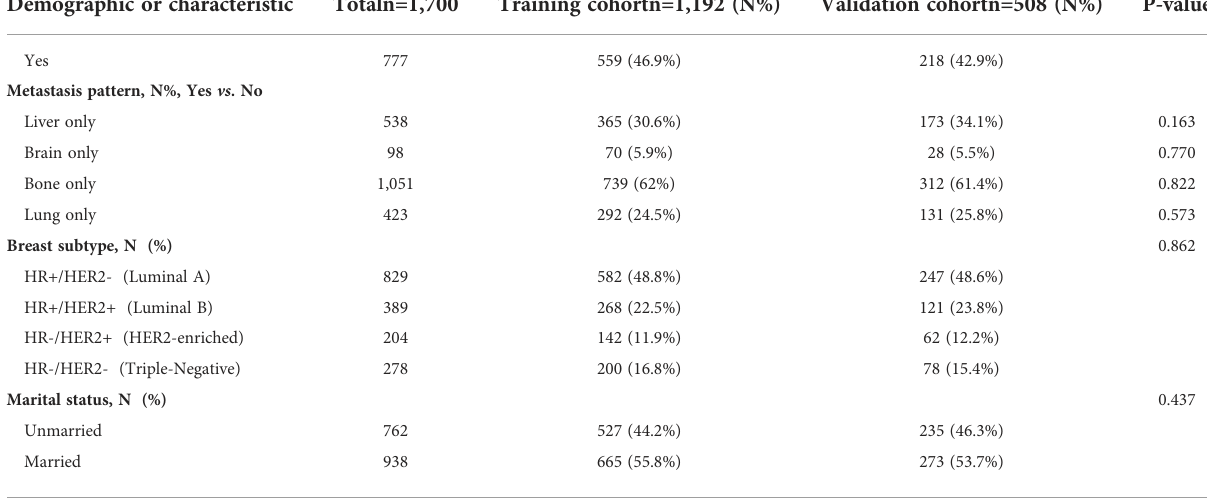
(Figure 5). Data from the veri fi cation analysis are presented in the Supplementary Material and Figure